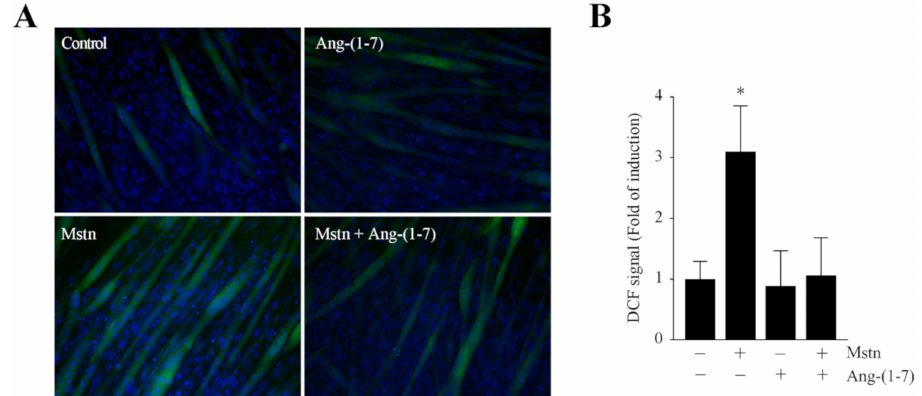
Figure 4. Ang-(1-7) reduced the reactive oxygen species (ROS) production induced by myostatin in the myotubes. ( A ) C 2 C 12 myotubes were incubated with myostatin (Mstn, 1 µ g / mL) for 24 h in the presence or absence of Ang-(1-7) (10 nM; pre-incubated for 1 h). The ROS levels were then determined by the detection of fluorescence using a CM-DCF-DA probe. The nuclei were labelled with Hoechst. The scale bar represents 100 µ m. ( B ) Quantification of the DCF-positive myotubes. The values are expressed as a fold of induction relative to the myotubes without treatment, and correspond to the mean ± SD from three independent experiments ( n = 3; * p < 0.05 vs. control without